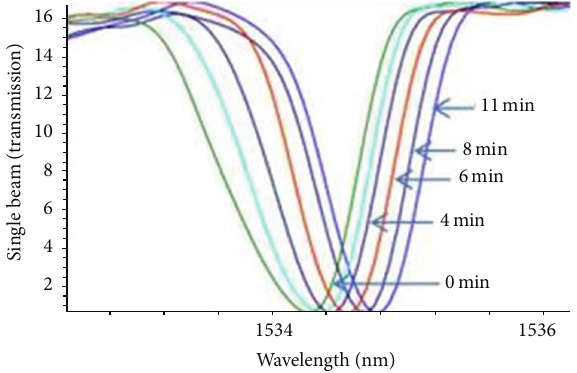
Figure 4: Bragg wavelength shifts as a function of time of water ingress.